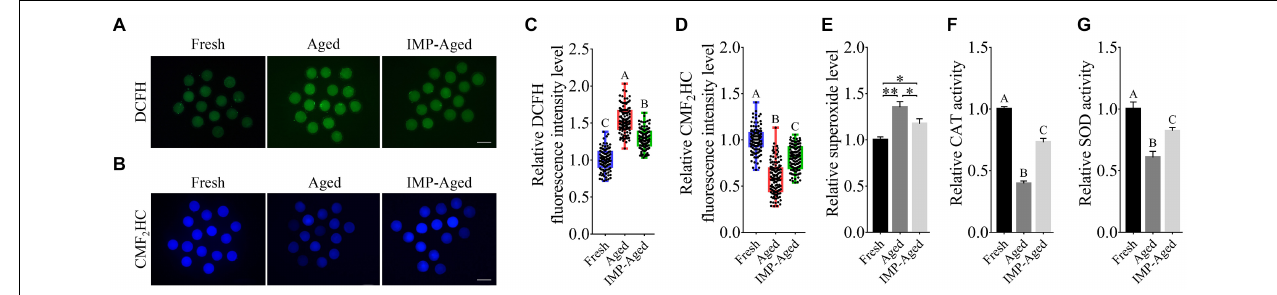
FIGURE 4 | Effects of IMP on oxidation resistance in aged oocytes. (A) Representative DCFH staining images of oocytes in fresh, aged, and IMP-treated group. Scale bar = 100 µ m. (B) Representative CMF 2 HC staining images of oocytes in fresh, aged, and IMP-treated group. Scale bar = 100 µ m. (C) Relative DCFH fluorescence intensity (represents ROS) level in fresh ( N = 120), aged ( N = 123), and IMP-treated aged oocytes ( N = 119). R = 3. Significant differences are represented by different capital letters ( P < 0.01). (D) Relative CMF 2 HC fluorescence intensity (represents GSH) level in fresh ( N = 127), aged ( N = 124), and IMP-treated ( N = 127) groups. R = 3. Significant differences are represented by different capital letters ( P < 0.01). (E) Relative superoxide level change in fresh, aged, and IMP-treated aged groups. R = 3. * P < 0.05; ** P < 0.01. (F) Relative CAT level change in fresh, aged, and IMP-treated aged groups. R = 3. Significant differences are represented by different capital letters ( P < 0.01). (G) Relative SOD level change in fresh, aged, and IMP-treated aged groups. R = 3. Significant differences are represented by different capital letters ( P < 0.01).